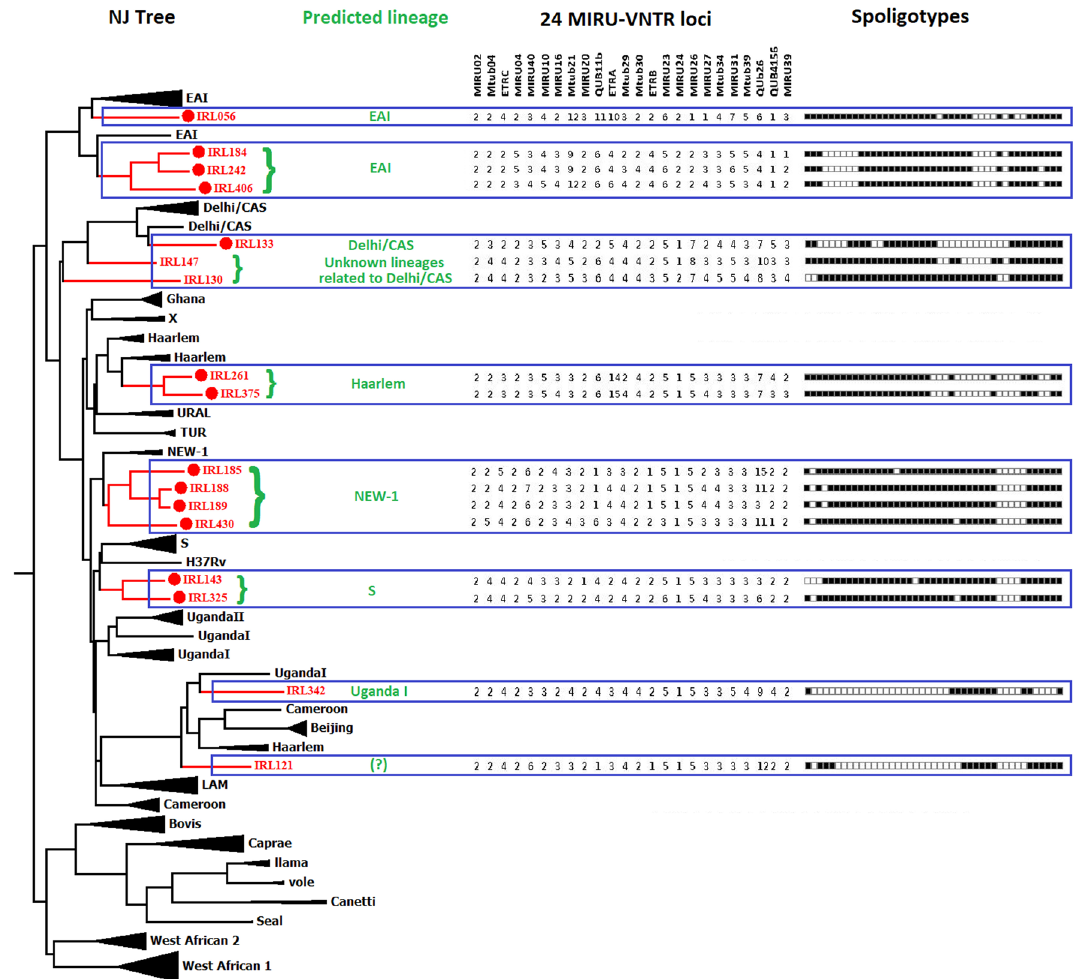
Figure 2. Neighbor-Joining (NJ) tree showing the phylogenetic relationship of orphan strains of MTBC from Sikkim with reference MTBC isolates available at the MIRU-VNTR plus database. The NJ tree was constructed using spoligotyping and 24-loci MIRU-VNTR data. MIRU-VNTR alleles and spoligo-patterns from 17 isolates are also represented along with the NJ tree. This phylogenetic tree was used to predict lineage of the orphan/